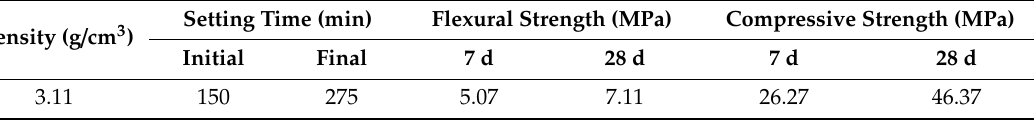
Table 2. Physical properties of the cement.